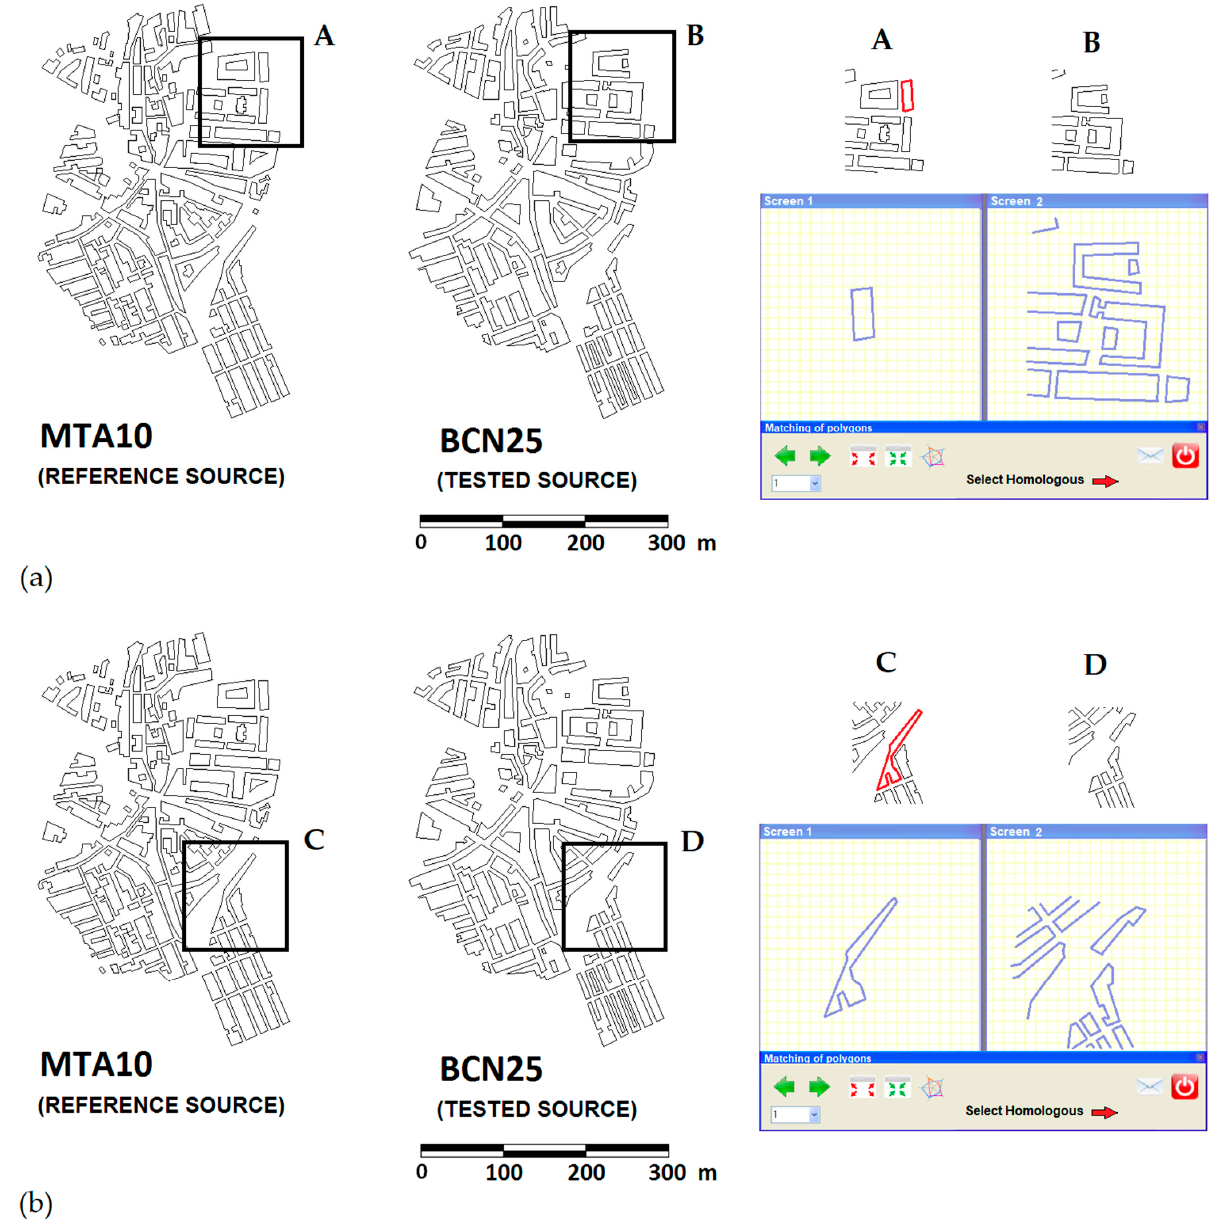
Figure 10. Unmatched polygons cases. ( a ) Unmatched polygons associated with 1:0 correspondences; ( b ) unmatched polygons associated with m:n correspondences.